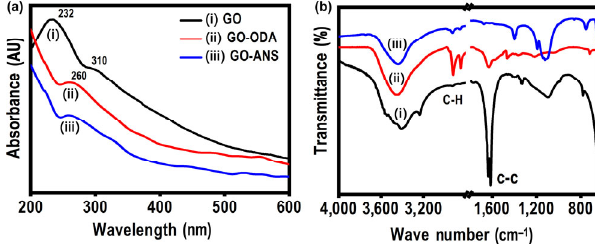
Fig. 1 (a) UV-Vis absorption spectra of GO, GO-ANS in aqueous and GO-ODA in chloroform medium. (b) FT-IR transmittance spectra of GO, GO-ODA and